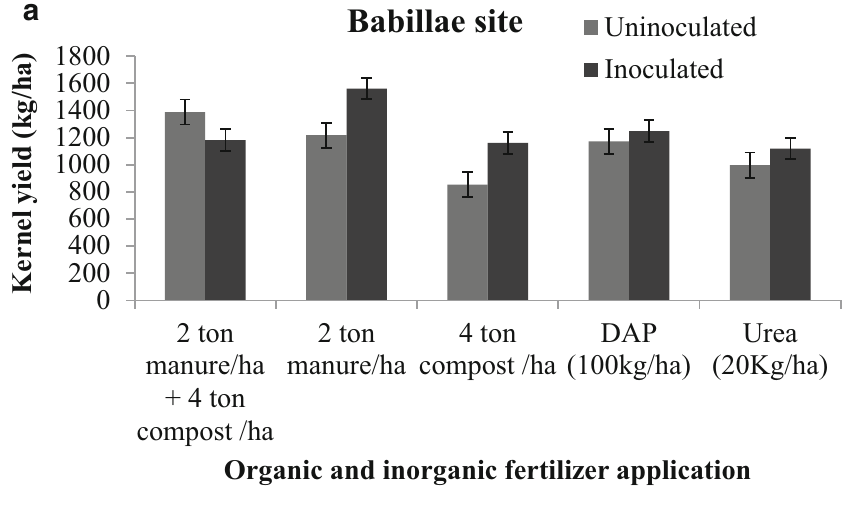
Fig. 3 Effect of Bradyrhizobium inoculation on grain yield of peanut at a Babillae and b